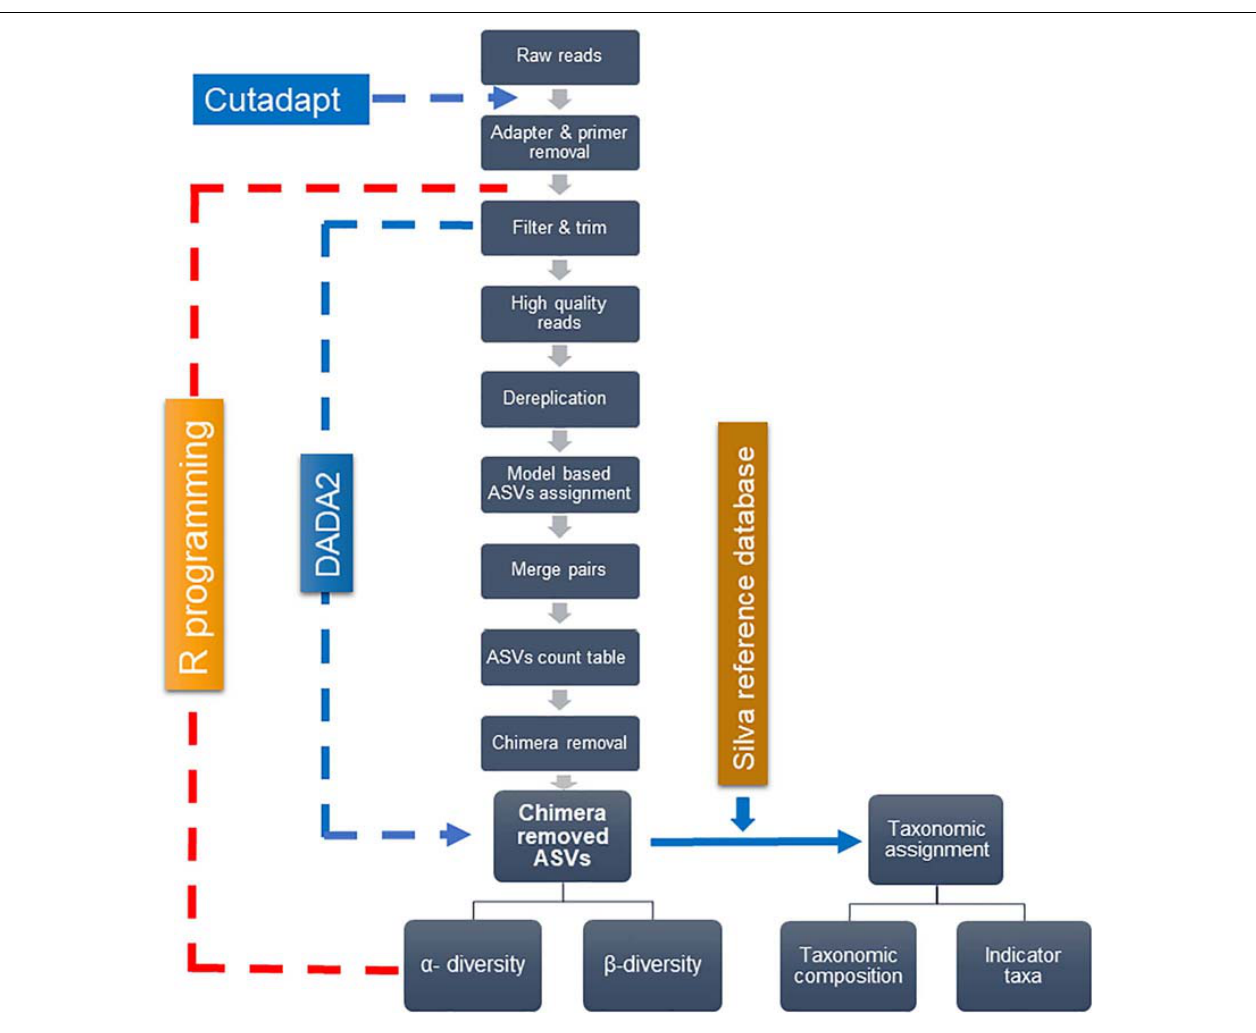
FIGURE 2 | Analytical pipeline for main bioinformatics